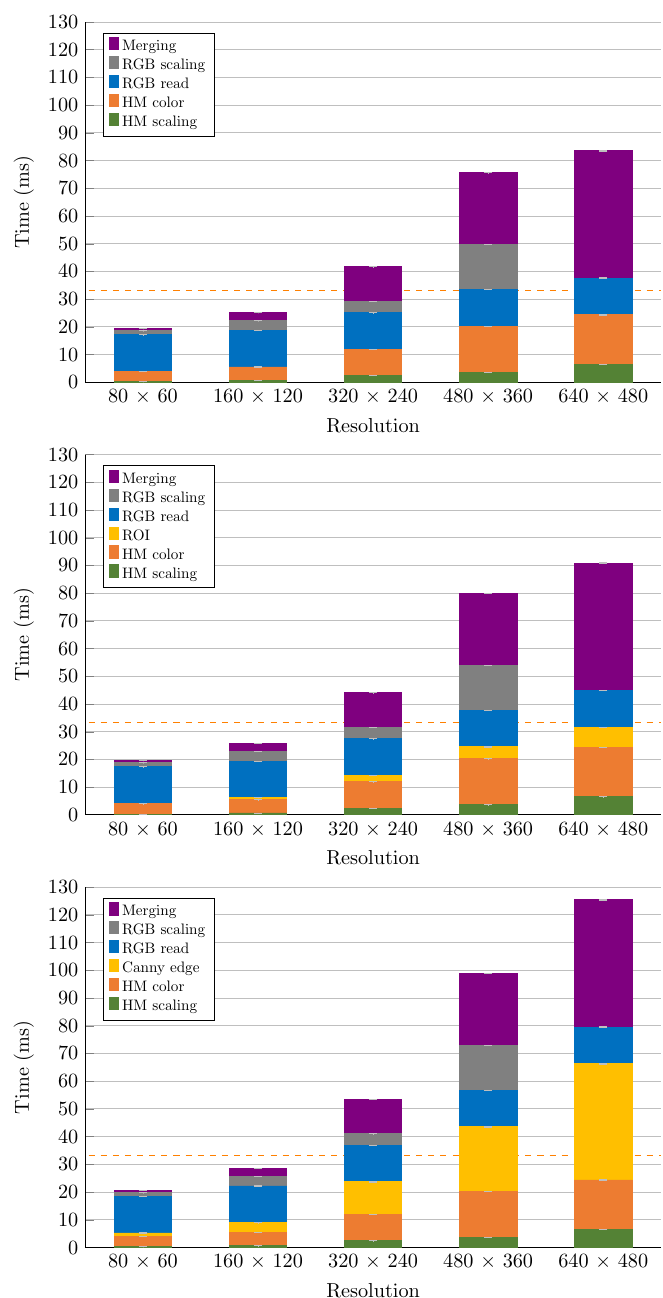
Figure 22. Time for each computational operation in Mode 3 ( left ), Mode 4 ( center ) and Mode 5 ( right ) for different resolutions. The orange line represents the threshold of 33 ms (30 FPS). The gray lines indicate the confidence